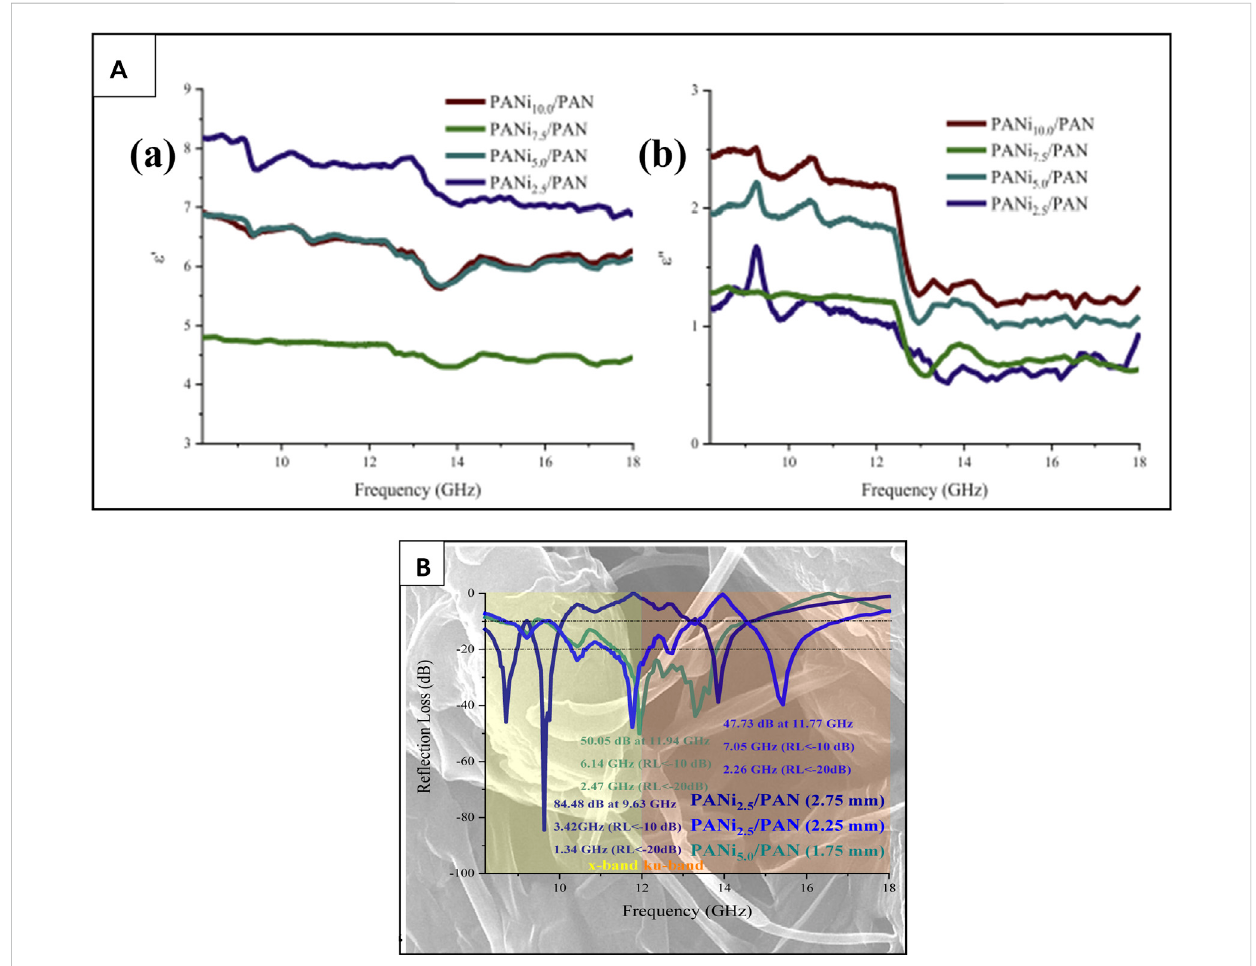
FIGURE 12 (Aa,b) Relative complex permittivity of the samples and (B) microwave absorption of the manipulated PANi from 8.2 to 18 GHz (Peymanfar et al., 2021b)